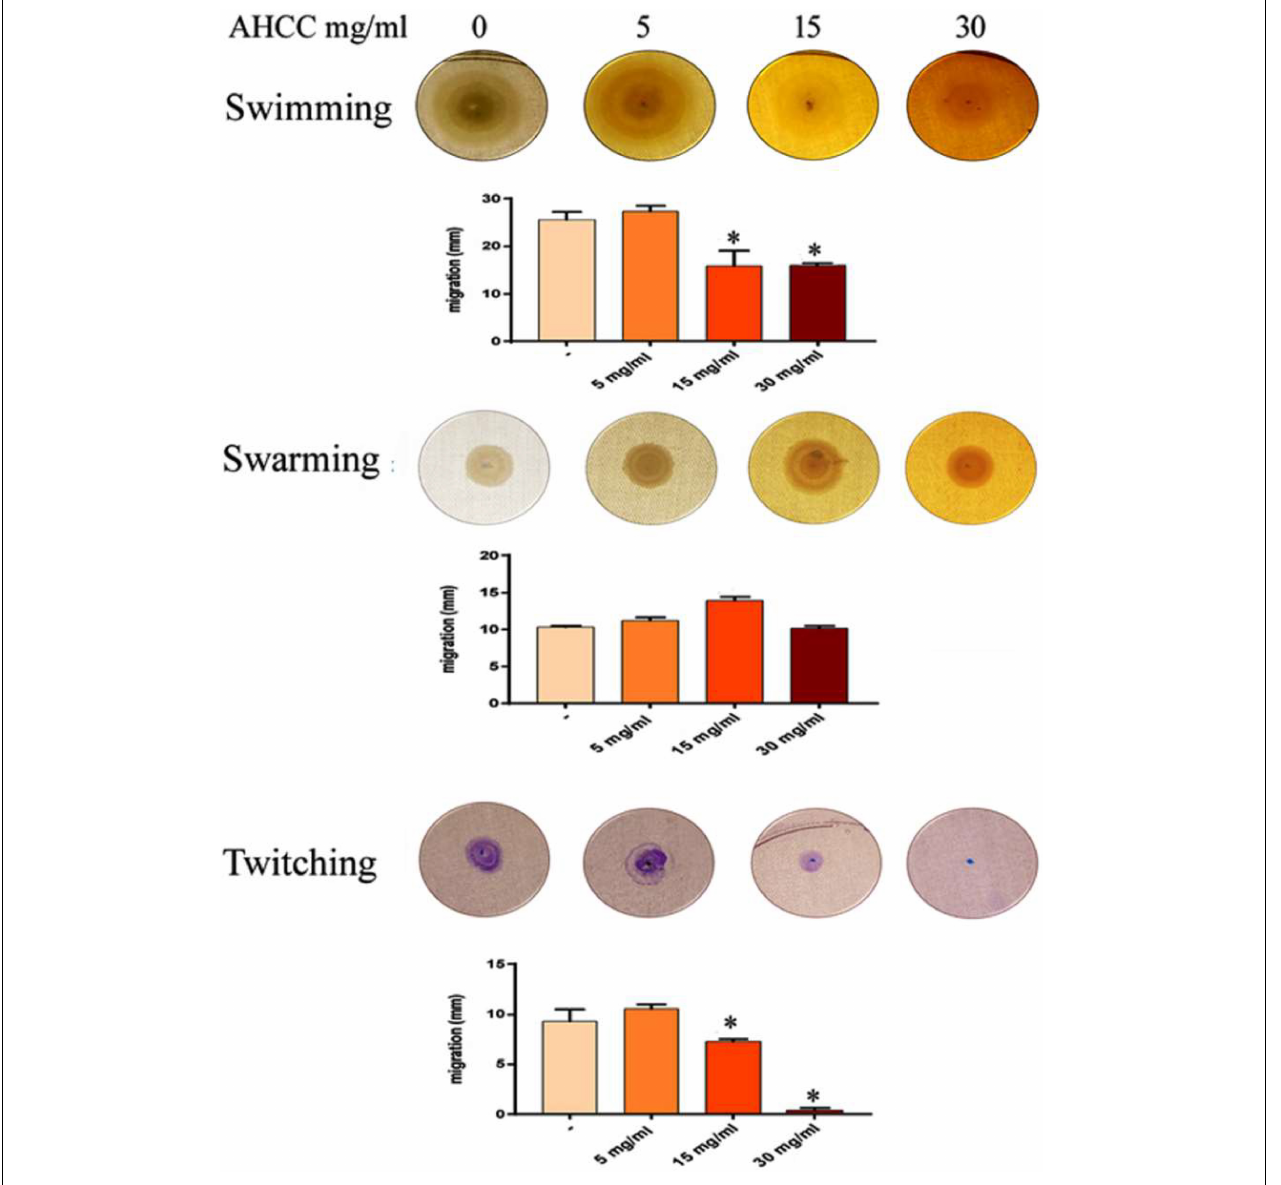
FIGURE 3 | Effects of AHCC R (cid:13) on the motility of P. aeruginosa. Motility assays were carried out as described in Materials and Methods. AHCC R (cid:13) at 5, 15 and 30 mg/mL was present in the agar plates and in the bacterial suspension. ∗ p < 0.05 vs. control (ANOVA followed by least significance